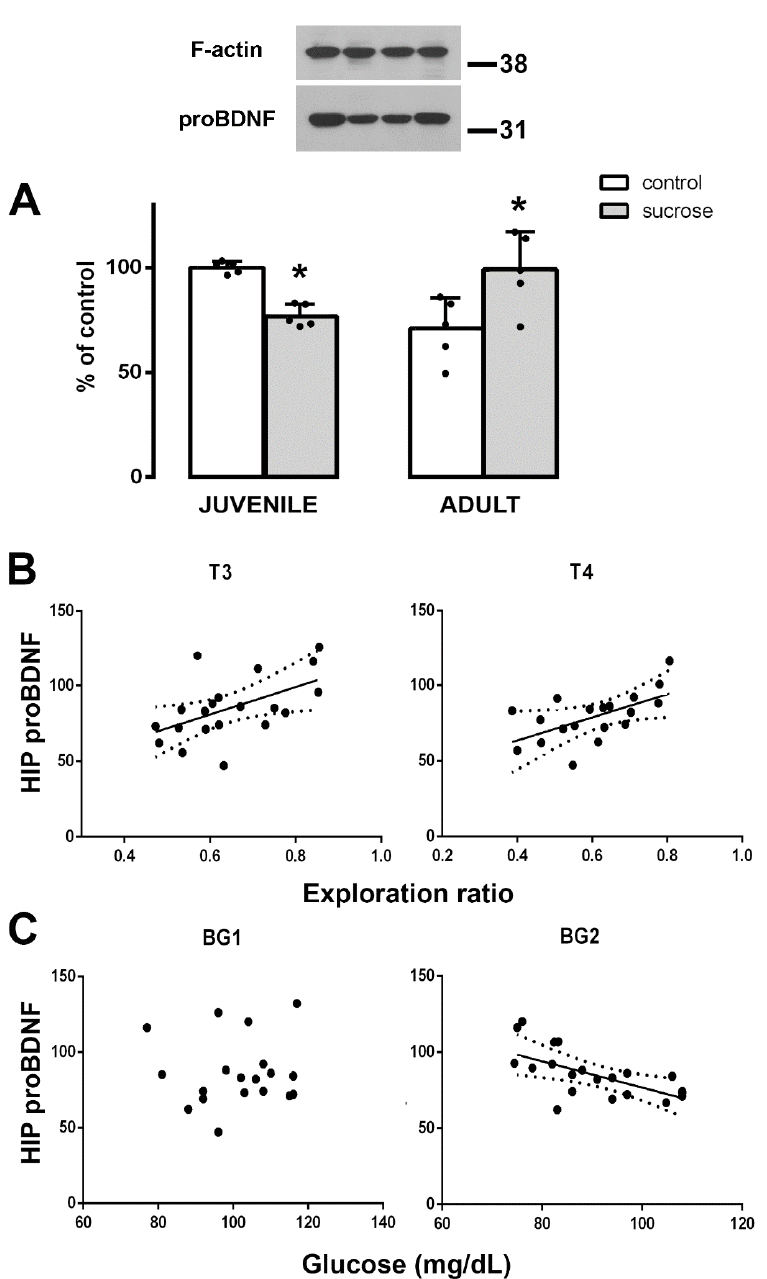
Figure 7. ( A ) Western blot of proBDNF in the HIP of control (white bars) and sucrose-exposed (gray bars) animals from juvenile or adult groups. Data were quantified by densitometric analysis and corrected with reference to the F-actin loading control. Representative pictures of proBDNF expression and the F-actin loading control are shown in the upper panel. Data are presented as mean ± SD from two independent experiments, n = 5. Tukey’s post hoc test, * p < 0.05. ( B ) Correlations between the hippocampal proBDNF levels and the NOR exploration ratios T3 and T4. Correlation equations of T3, y = 26.33 + 90.88x and T4, y = 32.88 + 76.35x. ( C ) Correlations between the hippocampal proBDNF levels and BG1/BG2. Correlation equation of BG2, y = 163.113 − 0.864x. Each point represents a value corresponding to an individual animal in the control and sucrose groups of both ages. Dotted curves represent the 95% confidence intervals.